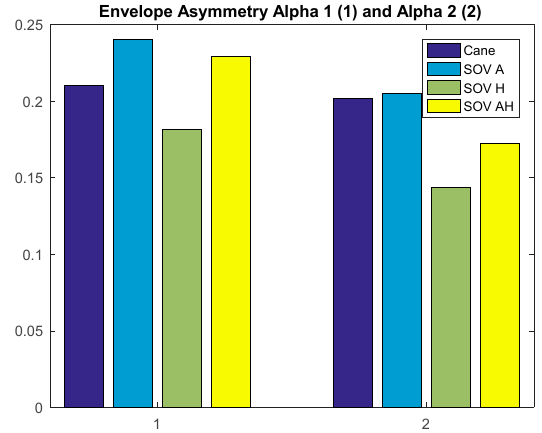
Figure 25. Average envelopes’ asymmetries for all users, for scenario E.